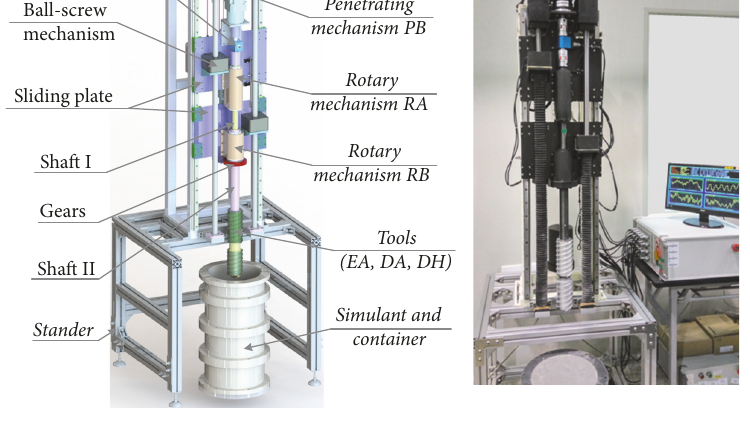
Figure 8: Drilling test bed.